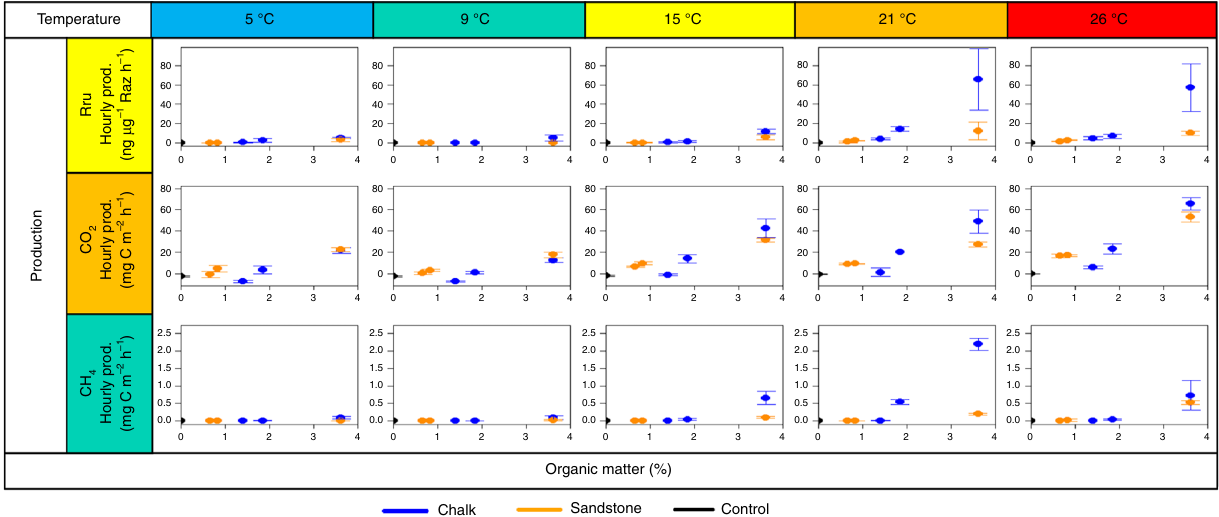
Fig. 3 The effect of organic matter on microbial metabolic activity and greenhouse gas production from stream sediments. Hourly production of Resoru fi n, CO 2 and CH 4 plotted against organic matter content for each temperature (5, 9, 15, 21 and 26 °C) for Chalk (blue), Triassic Sandstone (orange) and control (black) experiments. The error bars represent one standard